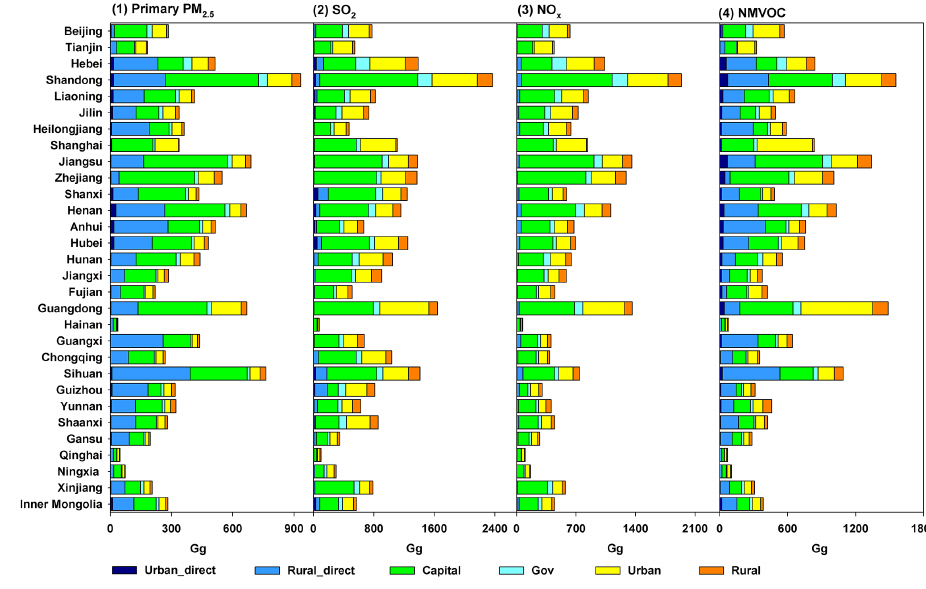
Figure 2. Consumption-based emissions in 2007 by province and final demand categories.